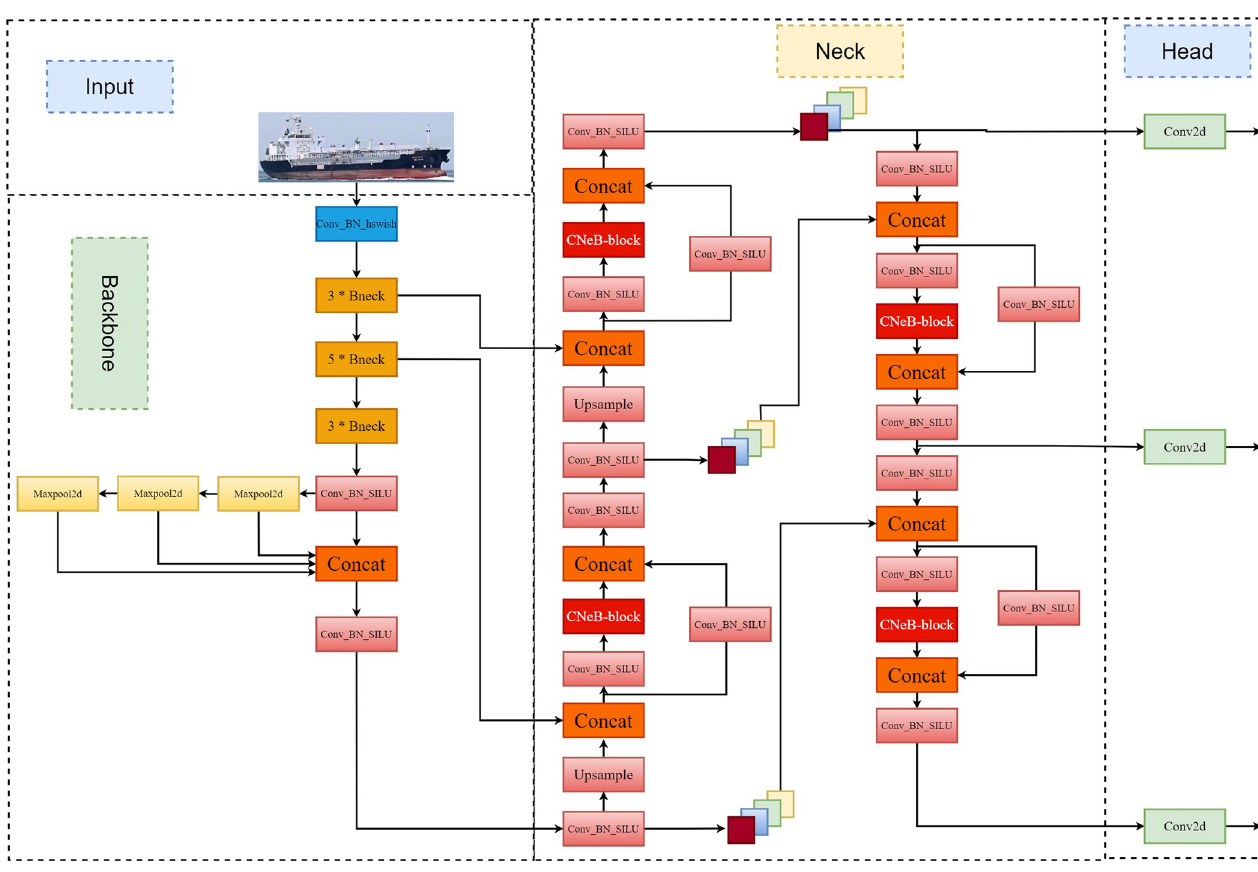
Fig 2. MC-YOLOv5s network structure.